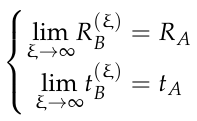
B absorbs all perspective distortions (Figure 4). With known